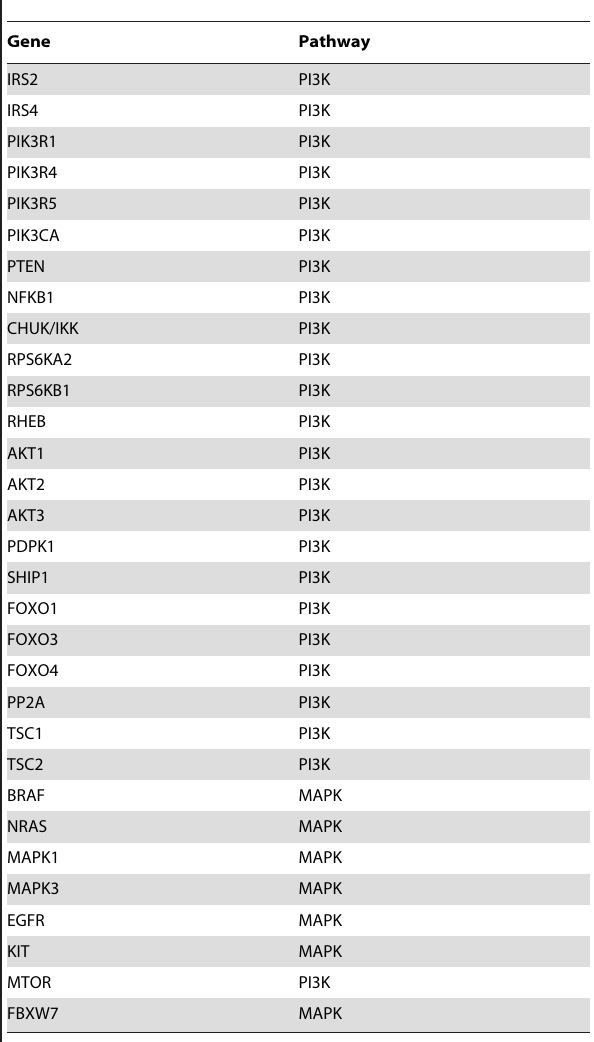
Table 1. List of PI3K and MAPK pathway genes sequenced.